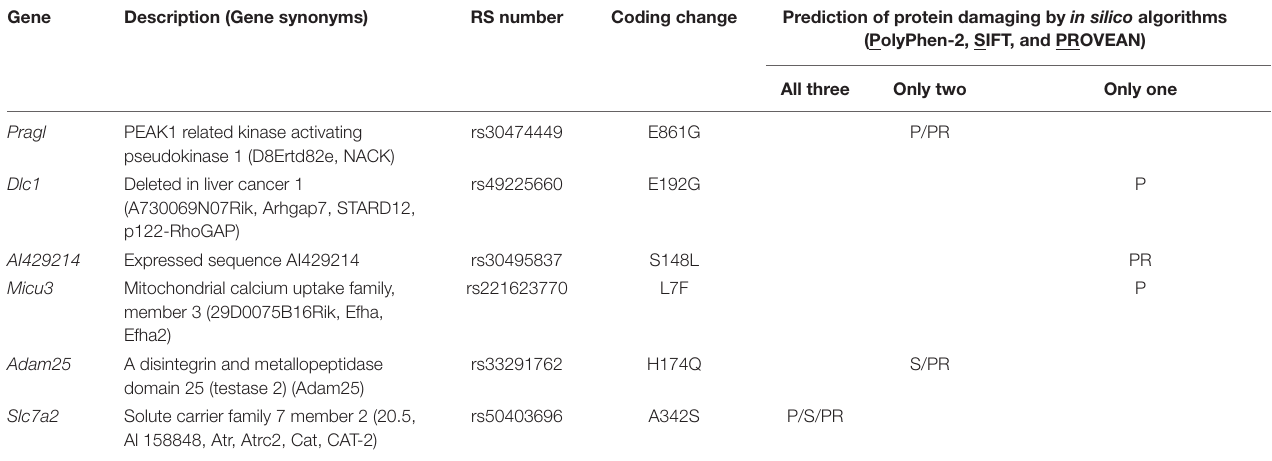
TABLE 3 | Candidate genes within the 1.5-LOD support interval that have coding SNPs predicted to be damaging for the B6 allele.